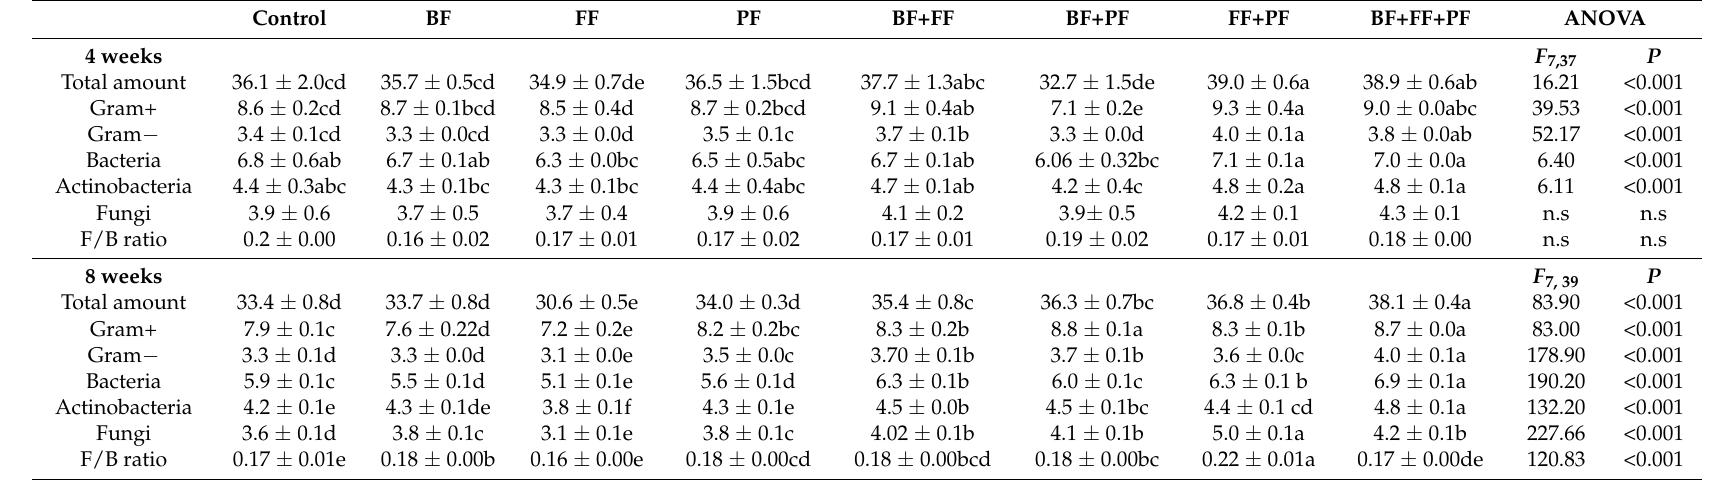
Table 1. Effects of inoculation of nematode trophic groups on the total amount of phospholipid fatty acids (PLFAs in nmol g − 1 DW soil ± s.d.) and on PLFAs indicative for Gram-positive (Gram+), Gram-negative (Gram − ), bacteria in general (bacteria), actinobacteria, and fungi, and fungal/bacterial (F/B) PLFA ratio in the rhizosphere soil of Quercus robur . Presented are data at 4 and 8 weeks after nematode inoculation. Control—no nematodes inoculated, bacterial feeders—BF ( Acrobeloides buetschlii ), fungal feeders—FF ( Aphelenchoides saprophilus ), plant feeders—PF ( Pratylenchus penetrans ) . Values within a row with at least one letter in common are not significantly different (Tukey HSD, p < 0.05). (Table from Maboreke [35],